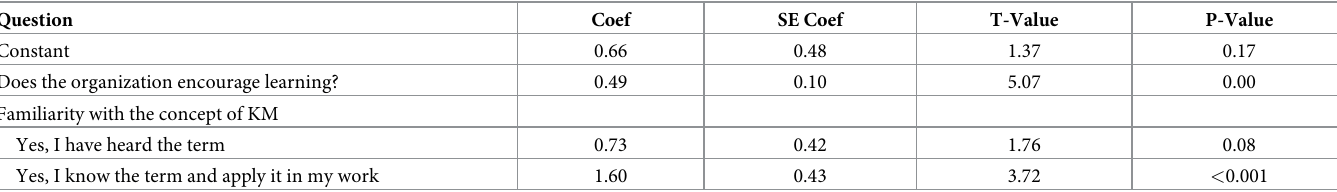
Table 4. One-way ANOVA for differences in professional experience in the organization and improvement of knowledge management on a personal level.